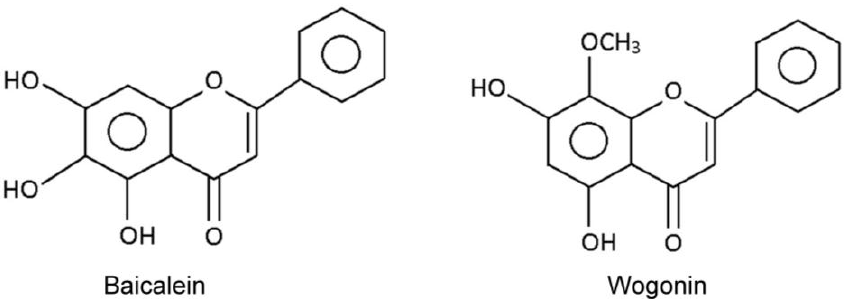
Figure 4. Structures of Baicalein and Wogonin.